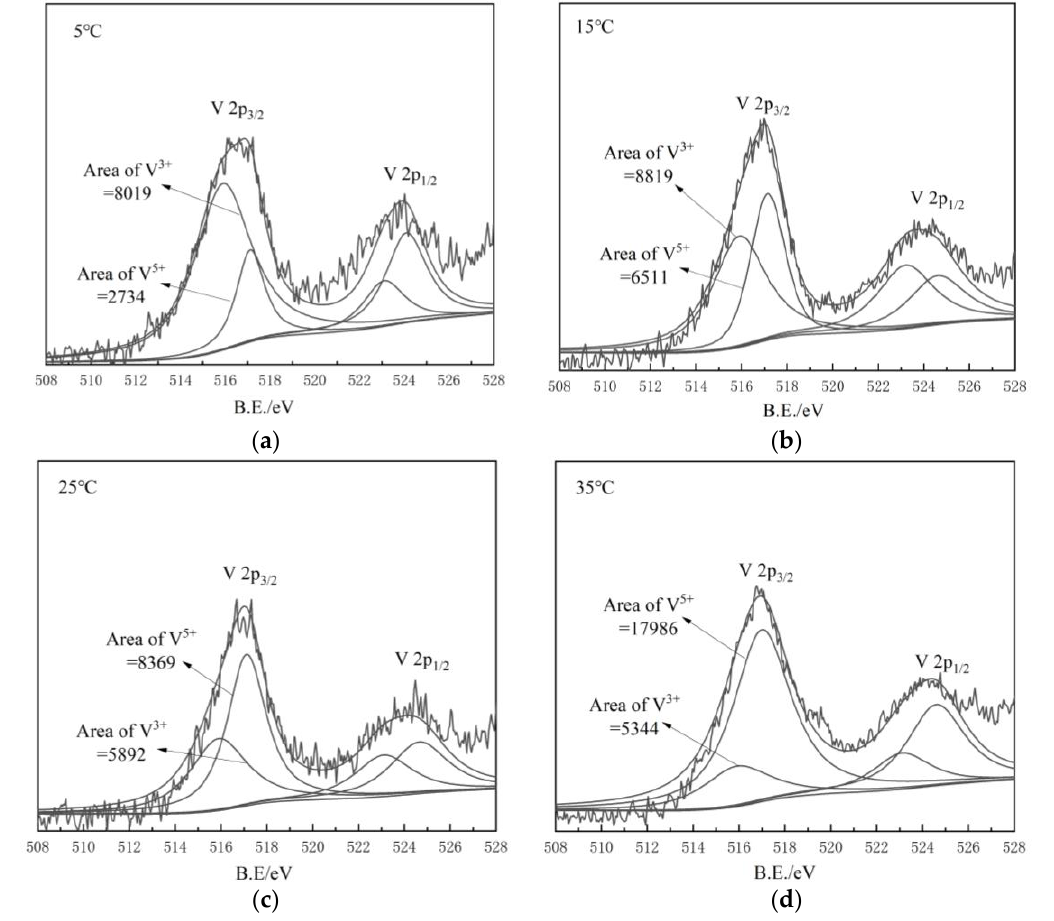
Figure 4. V 2 p 3/2 lines in PEO coatings fabricated at different electrolyte temperatures: ( a ) 5 °C; ( b ) 15 °C; Figure 4. V 2 p 3 / 2 lines in PEO coatings fabricated at di ff erent electrolyte temperatures: ( a ) 5 ◦ C; ( b ) ( c ) 25 °C; ( d ) 35 °C. 15 ◦ C; ( c ) 25 ◦ C; ( d ) 35 ◦